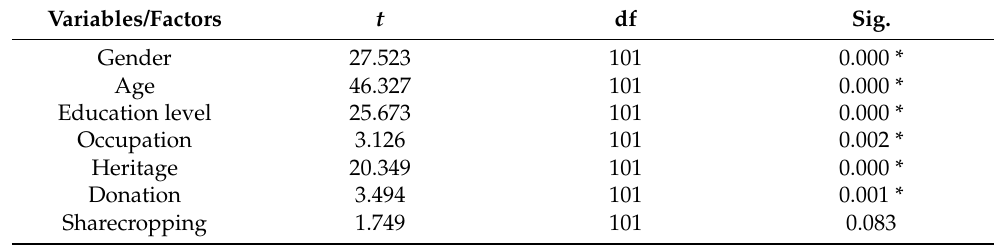
Table 6. The t -test of the effect of land access mode factors on agricultural entrepreneurial activities. Variables/Factors t df Sig. Gender 27.523 101 0.000 * Age 46.327 101 0.000 * Education level 25.673 101 0.000 * 3.126 101 0.002 * 20.349 101 0.000 * 3.494 101